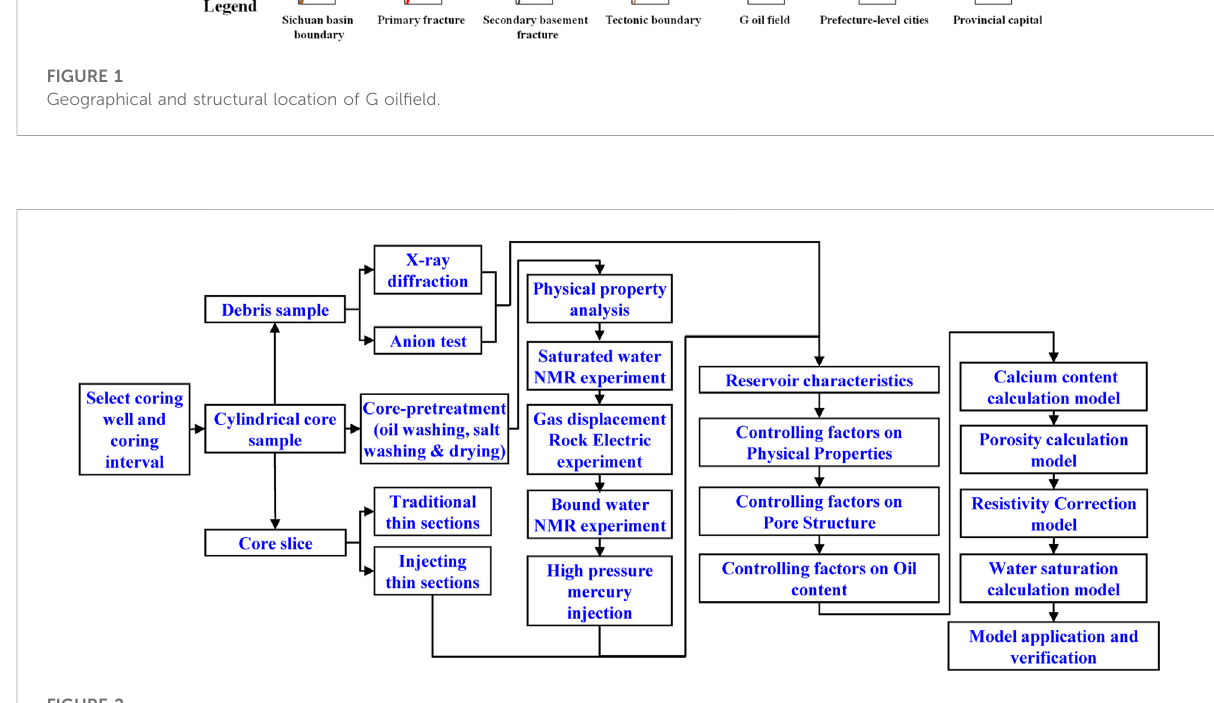
FIGURE 2 Experiment and research fl ow